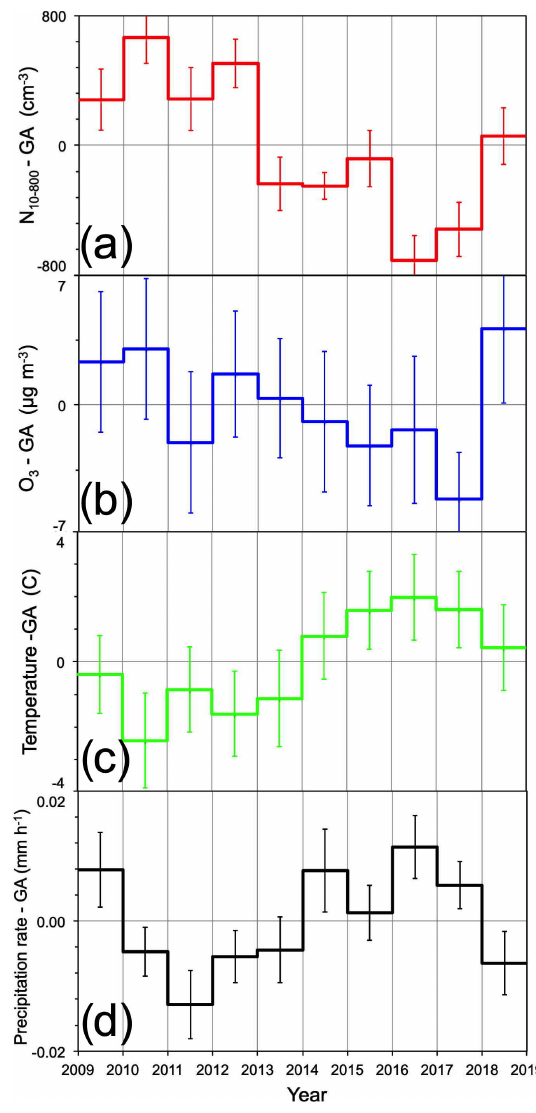
Figure 7. Trends in annual average deviations of (a) (cid:49)N 10 − 800 , (b) (cid:49) O 3 , and (c) temperature (cid:49)T along the trajectories 5d back in time, as well as (d) precipitation rate (cid:49) RR along the trajectories 3d back in time. The deviations are taken relative to the respective 10- year grand average (GA). The error bars represent the SDs of the annual